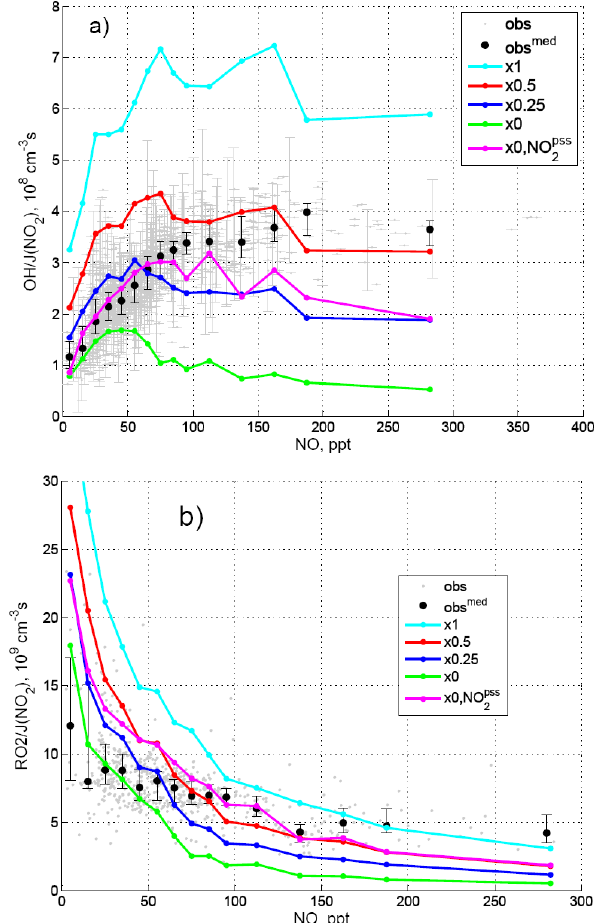
Figure 4. Normalized concentrations of OH (a) and RO 2 (b) versus measured concentrations of NO. Grey and black points represent observations; coloured lines – MCM calculations with [HONO] multiplied by a factor presented in figure legends (x0 corresponds to estimated steady-state HONO concentrations). Magenta – PSS [HONO] and [NO 2 ] is calculated by assuming PSS [NO 2 ] / [NO]